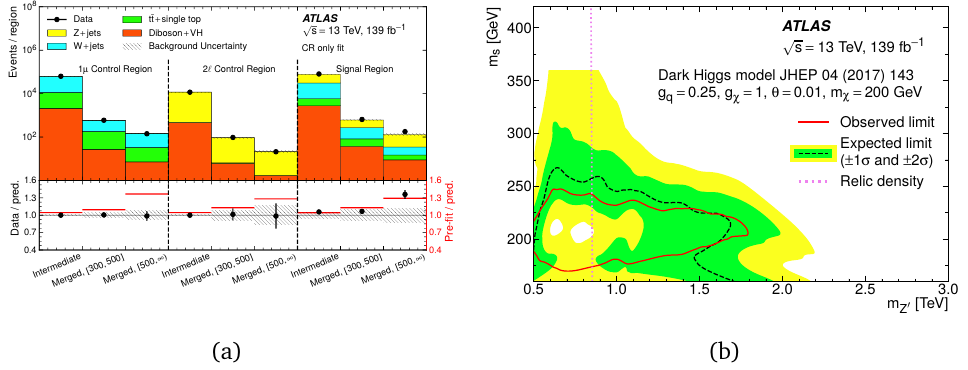
Figure 4: (a) Summary plot of the control and signal regions of the search for a dark Higgs in events with a large-R jet and E miss . (b) Constraints on the parameters of T proposed extended simplified DM models. Figures from [ 11 ]